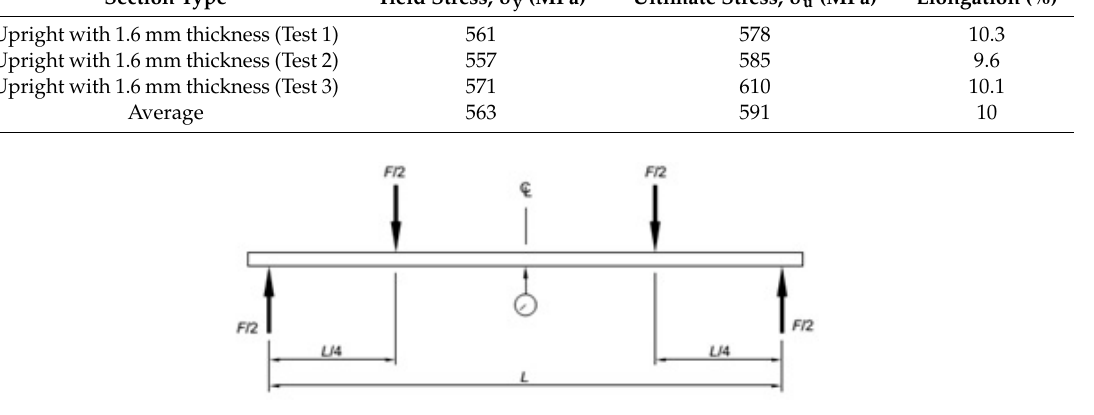
Figure 5. Typical schematic four-point bending test.